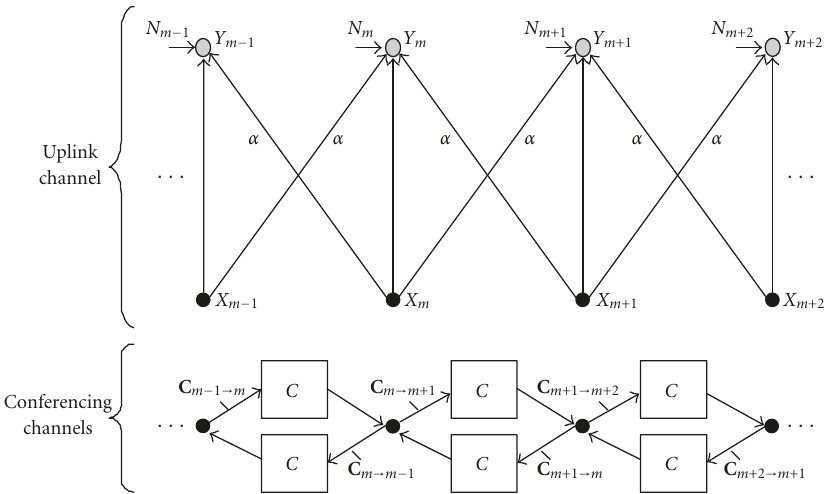
Figure 1: Linear Wyner model with inter-cell conferencing and intra-cell TDMA studied in Section 2.